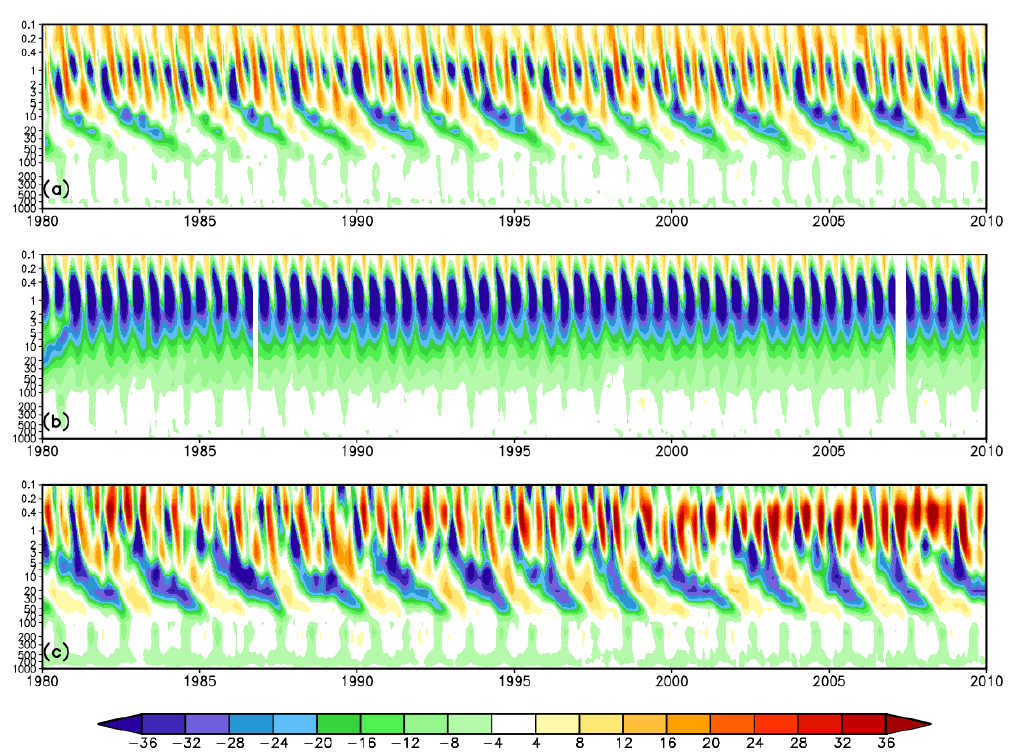
Figure 4. Spatial average of zonal wind in ms − 1 from 10 ◦ S to 10 ◦ N latitude as a function of pressure level in millibars and time from